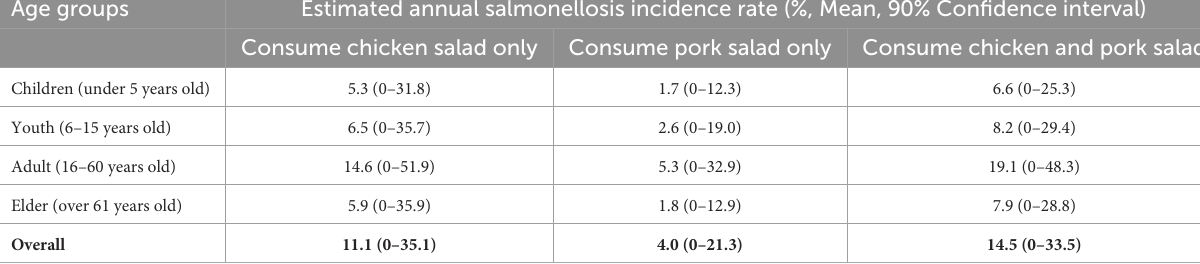
TABLE 4 The annual incidence rate of human salmonellosis due to chicken and pork salad consumption by age groups in Cambodia. Age